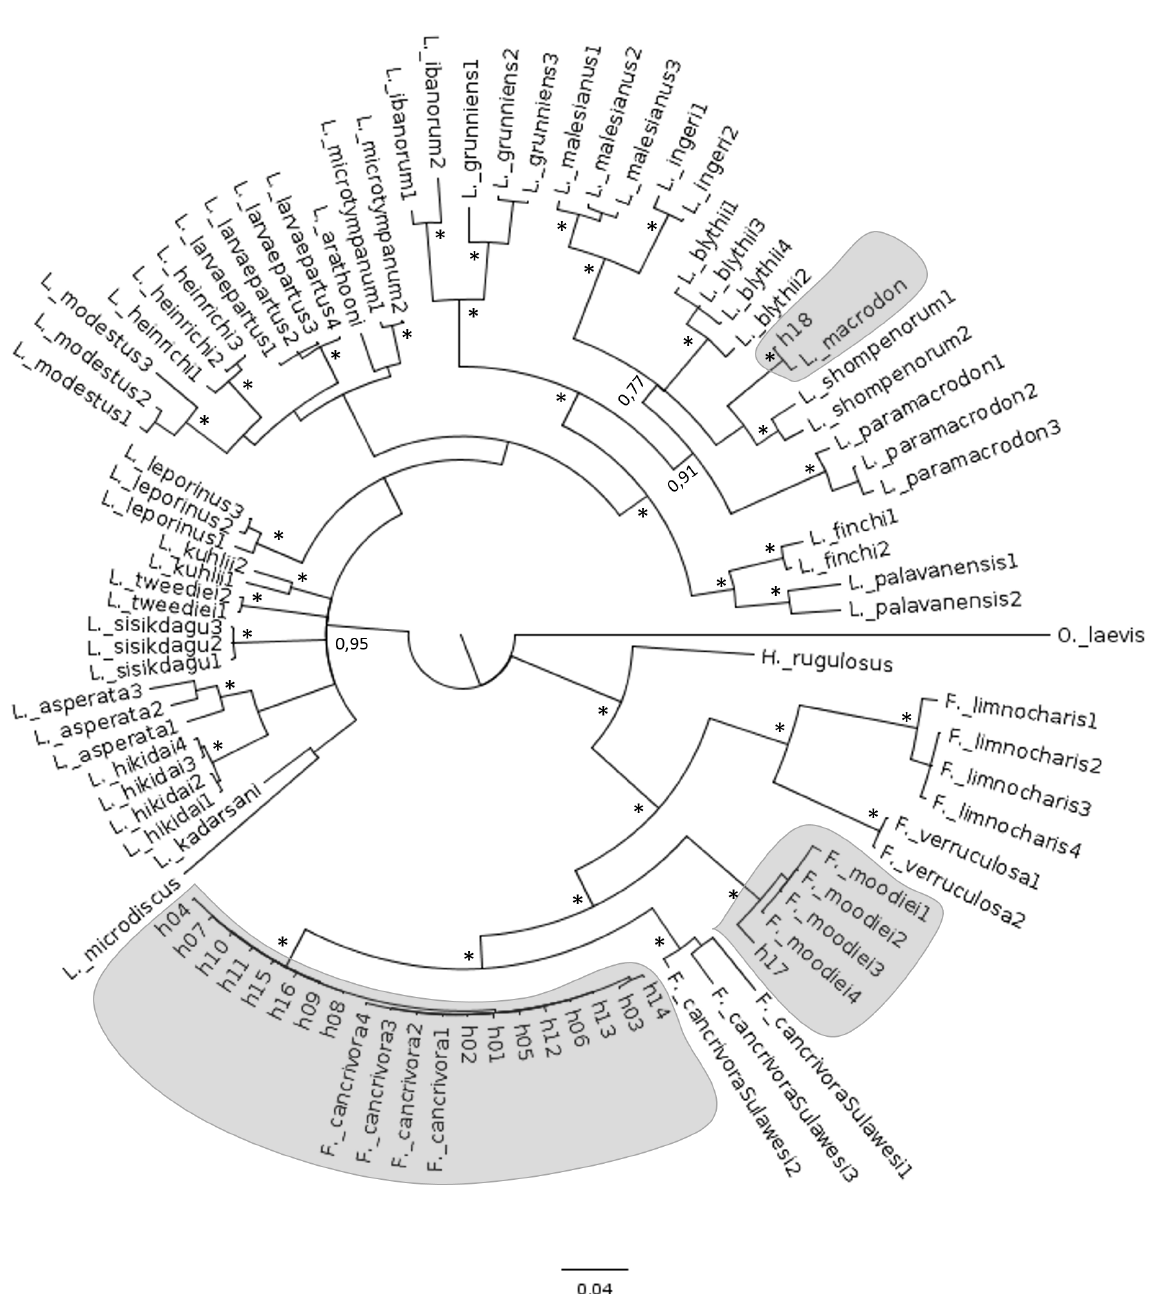
Fig. 1. Phylogeny of Indonesian species of Fejervarya and Limnonectes recovered by the Bayesian analysis (GTR + I + G model). Hoplobatrachus rugulosus (Wiegmann, 1834) and Occidozyga laevis (Günther, 1858) were used as outgroups. Numbers on nodes represent Bayesian posterior probabilities, * indicates a value higher than 0.98. Only values higher than 0.75 are represented. h01 to h18 indicate the 18 haplotypes from frozen frog legs recovered in this